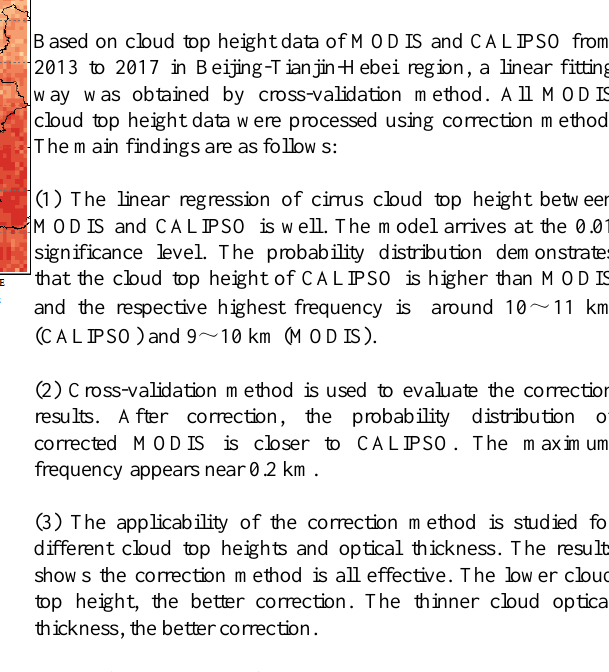
Figure 6. Distribution of raw and corrected cloud top height of cirrus during 2013-2017 (a, b and c represent raw height, corrected height, difference between corrected height and raw height, respectively)